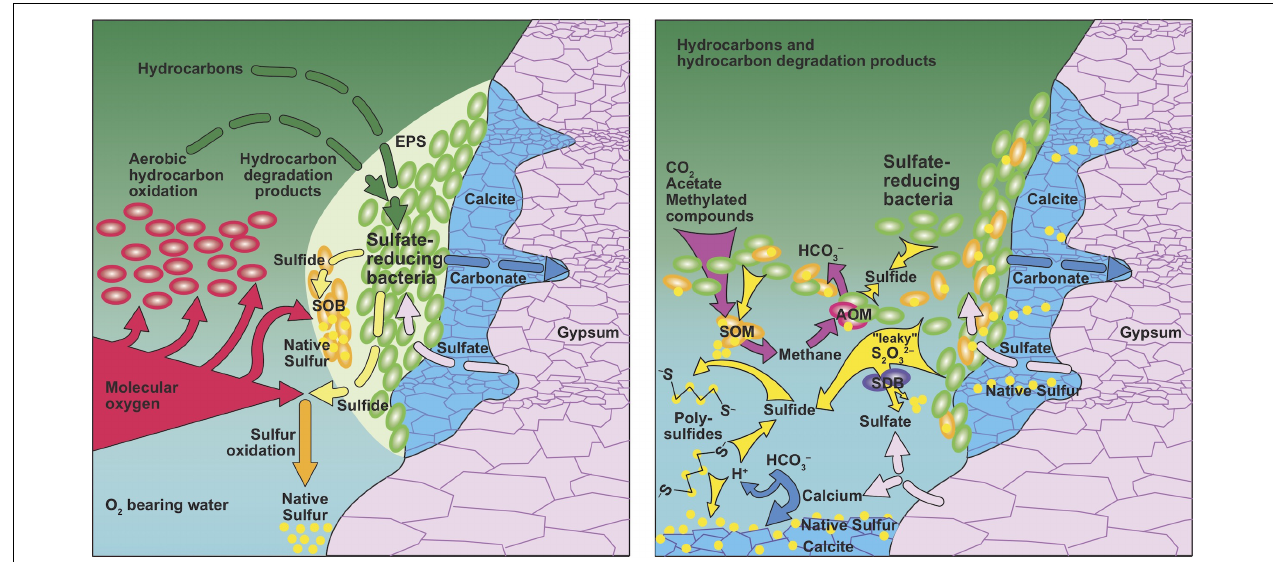
FIGURE 3 | Genesis of native sulfur in presence (left) and absence (right) of O 2 . (Left) In a system where native sulfur genesis is driven by supply with O 2 , there is a competion between oxygen-consuming aerobic hydrocarbon oxidation and oxidation of sulfide to native sulfur. Replacement of gypsum with carbonate is confined to the interface between solid gypsum and hydrocarbons in order to maintain low-oxygen conditions required for sulfate-reducing bacteria using extracellular polymeric substances (EPS). Sulfur-oxidizing bacteria (SOB) could help produce native sulfur in close association with sulfate-reducing bacteria. (Right) In an oxygen-free environment, sulfate reduction can take place detached from gypsum surfaces at the hydrocarbon-brine interface because gypsum dissolution provides sulfate to the brine. Sulfur cycling may include simultaneous genesis and consumption of methane and sulfate, constituting complete cryptic carbon and sulfur cycles. Sulfide-oxidizing microbes (SOM) produce methane and native sulfur. Sulfur disproportionating bacteria (SDB) convert sulfur compounds with intermediate oxidation state or native sulfur into sulfate and sulfide. Finally, anearobic oxidation of methane (AOM) consumes sulfate and methane. Sulfide can react with native sulfur to form polysulfides, a reaction that is reverted during carbonate precipitation, due to local increase in